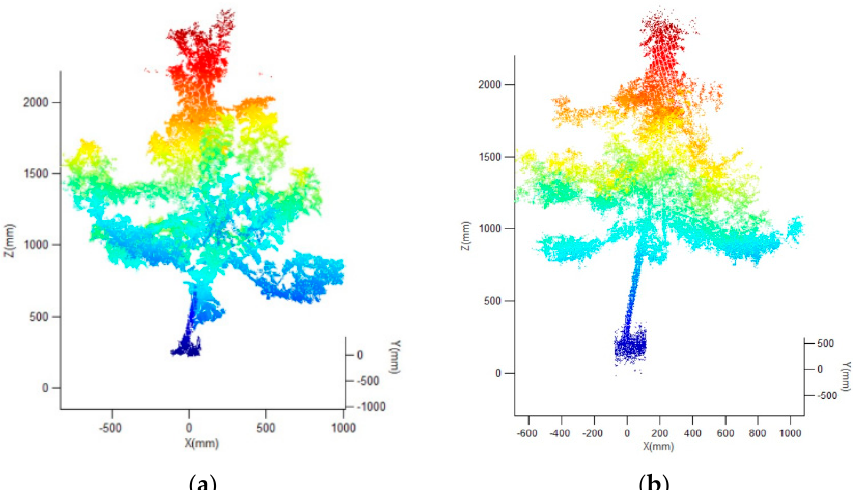
Figure 10. Part of 3D point cloud reconstruction for fruit trees: ( a ) 3D point cloud reconstruction for fruit tree a; ( b ) 3D point cloud reconstruction for fruit tree b.